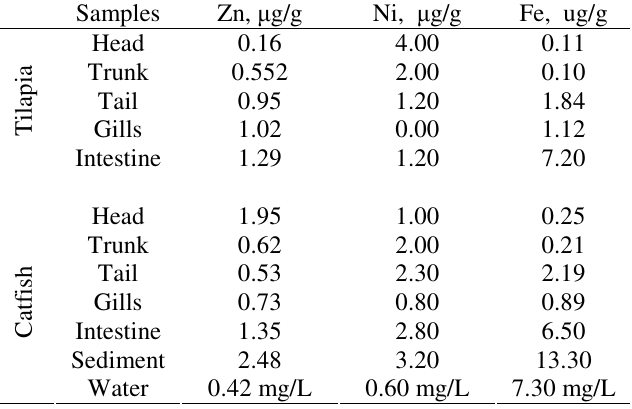
Table 1. Metal distribution in Epe Lagoon samples.